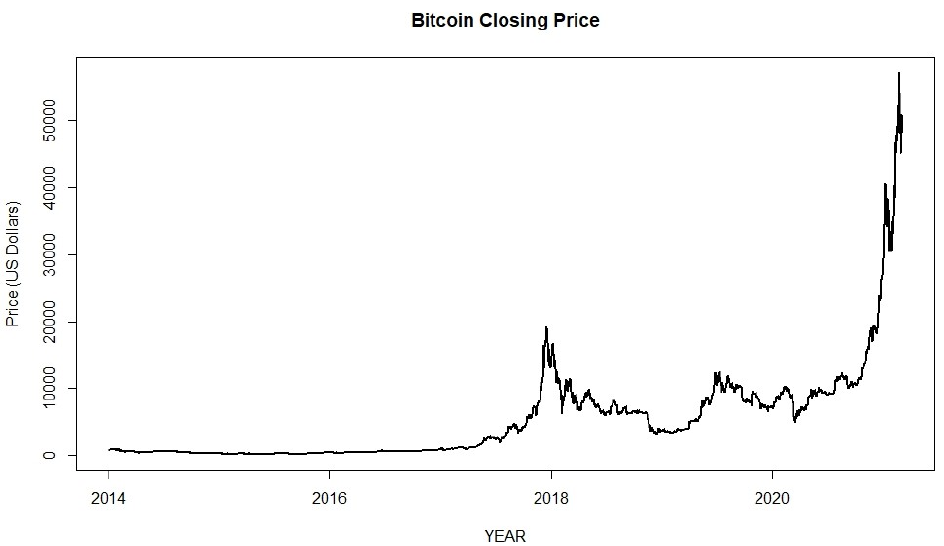
Figure 1. The course of Bitcoin prices over the years.